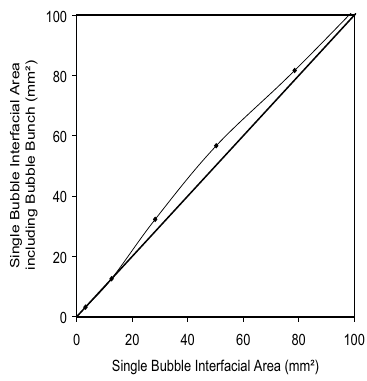
Figure 7. Interfacial area considering bubble bunch effect vs. interfacial area neglecting bubble bunch